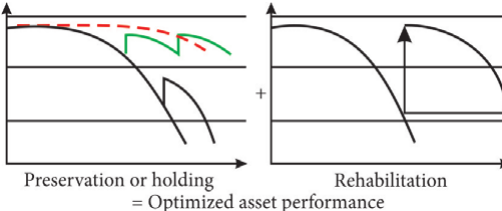
Fig. 11. Coordinated strategies of pavement